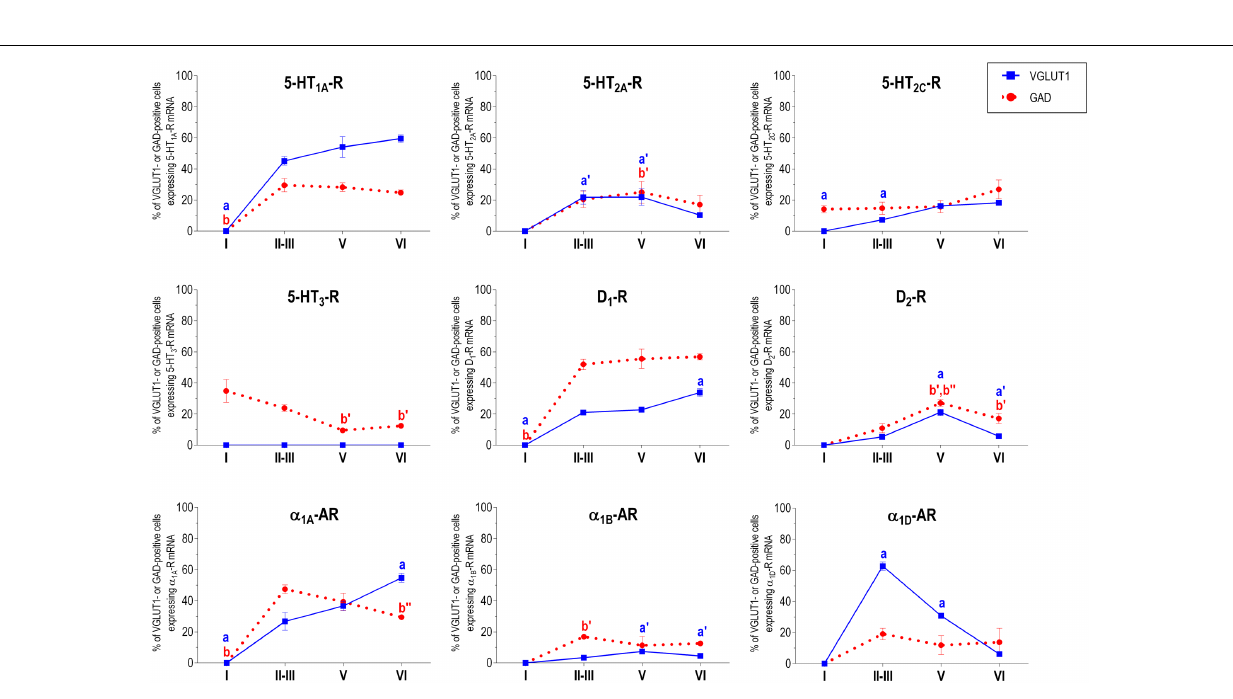
FIGURE 6 | Percentages of pyramidal (VGLUT1-positive) and GABA (GAD-positive) neurons expressing the nine monoamine receptors studied in the different layers of infralimbic area of medial prefrontal cortex. a p < 0.05 vs. rest of layers, a (cid:48) p < 0.05 vs. layer I; a (cid:48)(cid:48) p < 0.05 vs. layers II–III; a (cid:48)(cid:48)(cid:48) p < 0.05 vs. layer V (for VGLUT1 graphs). b p < 0.05 vs. rest of layers, b (cid:48) p < 0.05 vs. layer I; b (cid:48)(cid:48) p < 0.05 vs. layers II–III; b (cid:48)(cid:48)(cid:48) p < 0.05 vs. layer V (for GAD graphs), one-way ANOVA followed by Tukey’s